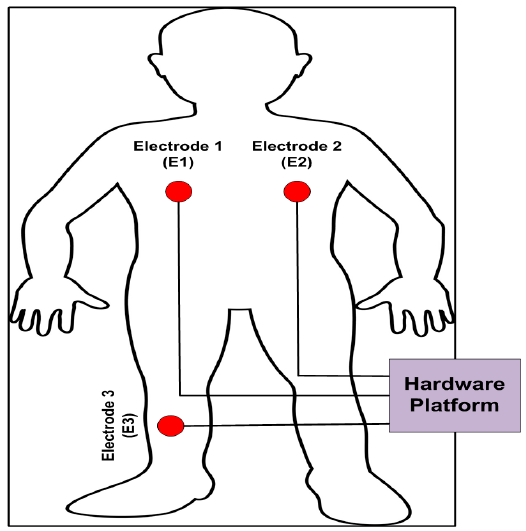
Figure 4. The measurement of electrocardiogram (ECG) with a single lead standard Holter.